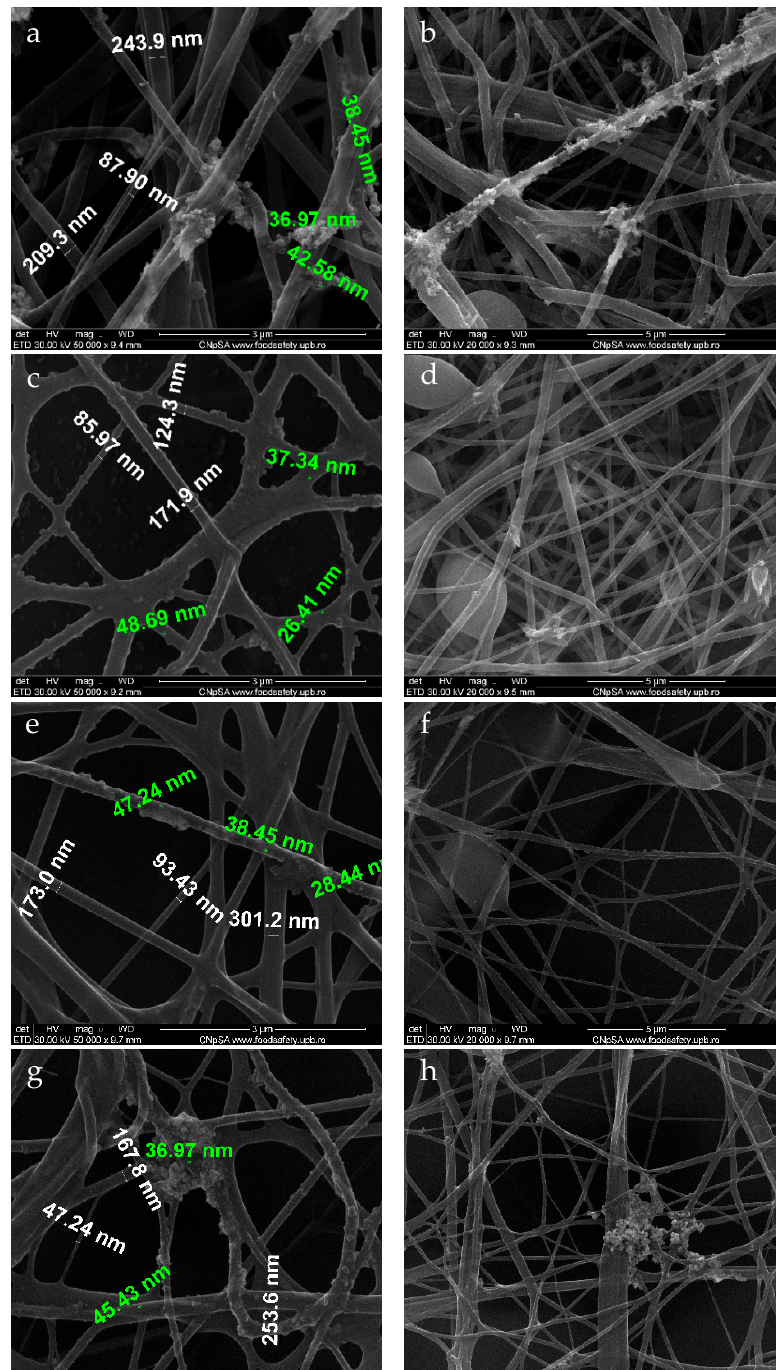
Figure 4. SEM images recorded for PET_X_NanoAg at various flows: ( a,b ) PET_2.5_NanoAg; ( c,d ) PET_5_NanoAg; ( e,f ) PET_7.5_NanoAg; ( g,h ) PET_10_NanoAg. Green text—dimensions for nanoAg; white text—dimensions for PET fibers.